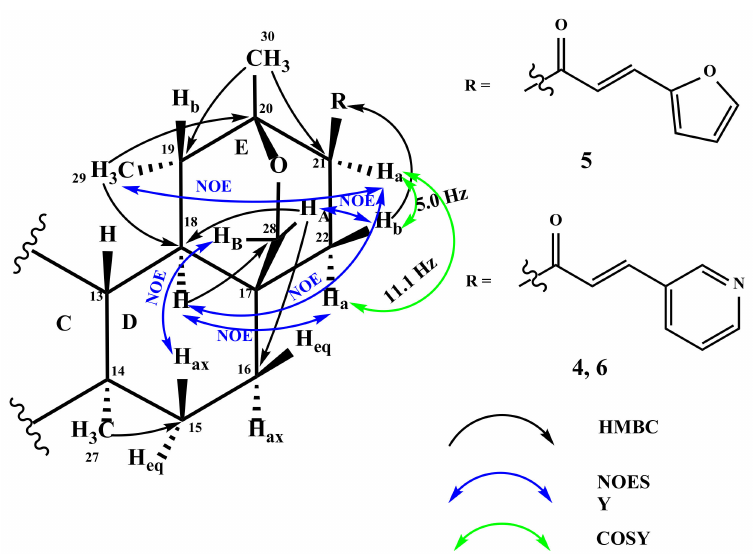
Figure 3. The key HMBC, COSY and NOESY correlations of compounds 4–6 . The E-configuration of double bond in 3-pyridinylidene and furfurylidene fragment at C21 was established from the value of 3 J = 15.9 Hz, that indicated trans arrangement 32-1 (cid:48) of protons at double bond. A similar situation is observed for compound 7 . The